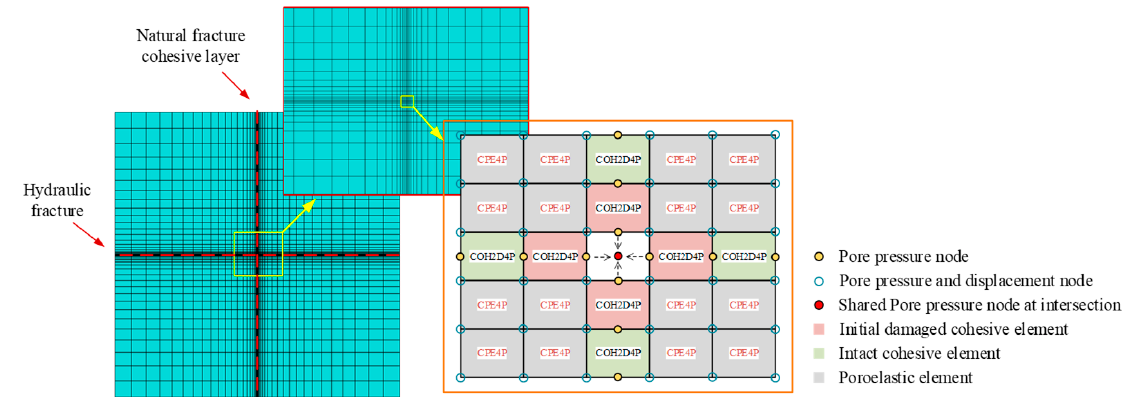
Figure 4. Schematic of arrangement of cohesive elements at the intersection of a hydrofracture with a fixed propagation direction and a pre-existing natural fracture.